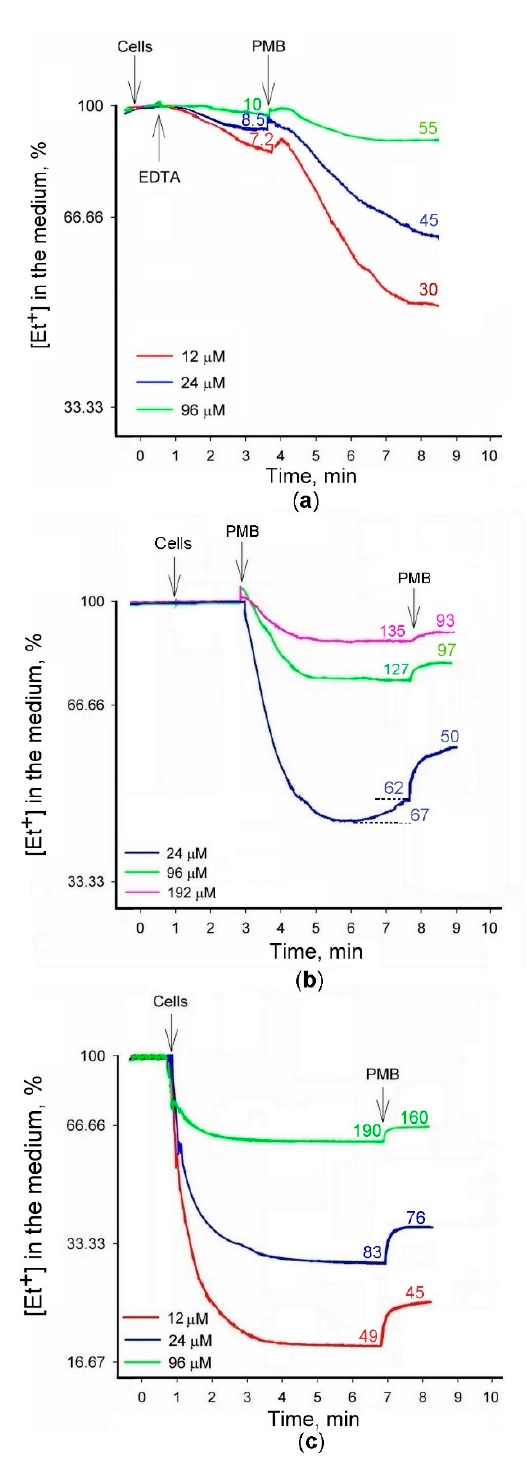
Figure 2. The binding of Et + to intact and heat-inactivated S. Typhimurium SL1344 wt cells incubated with different concentrations of this cation. Concentrated intact ( a , b ) or heat-inactivated ( c ) cell suspensions were added to 100 mM Tris/HCl buffer, pH 8.0, containing 0.1% glucose, to obtain OD 600 of 1. On Y-axes, Et + concentrations are presented in % of the initial ones. The initial concentrations of Et + are indicated in the figure. PMB was added to the final concentration of 50 mg/L ( a , c ) or 50 and 100 mg/L ( b ), EDTA to 1 mM. Numbers next to the curves indicate the amount (nmol) of Et + bound to the cells. The experiment was performed at 37 °C.